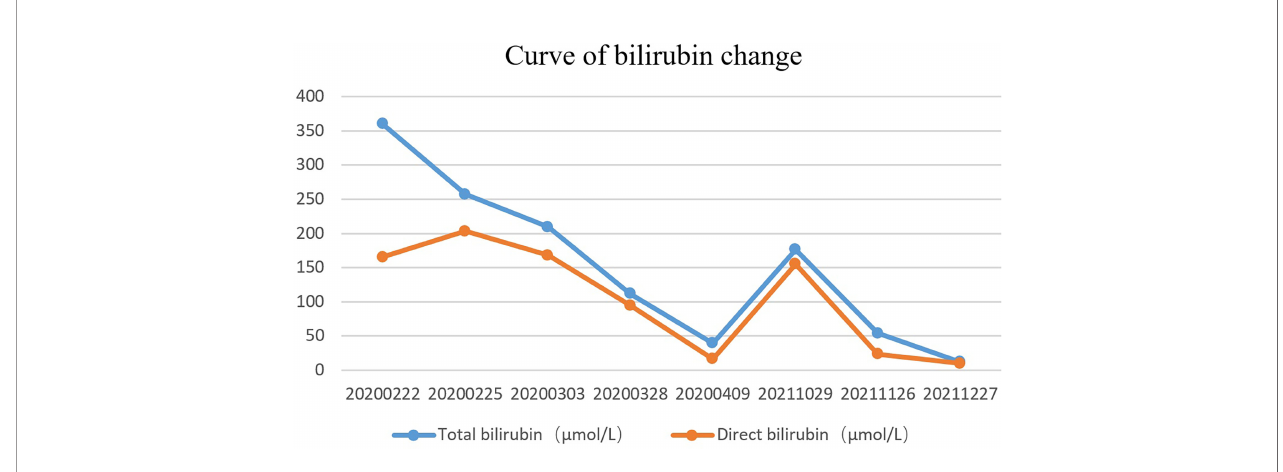
FIGURE 2 | Curve of bilirubin